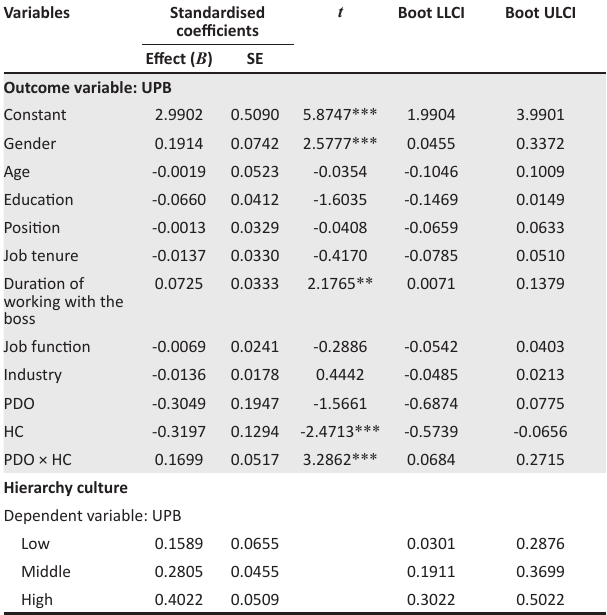
TABLE 5: Regression results for moderation effect on the relationship between power distance orientation and unethical pro-organisational behaviour. Variables